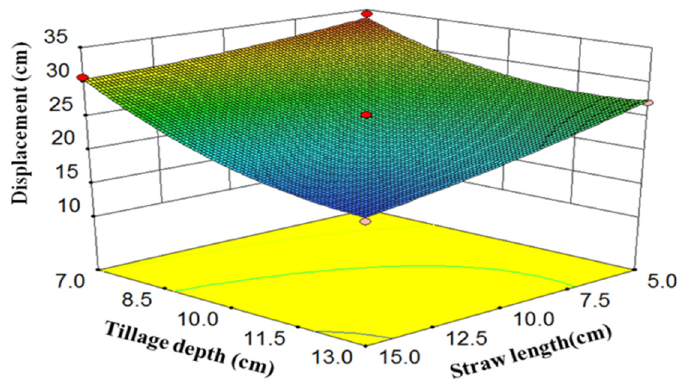
Figure 7. Response surfaces of straw length and tillage depth on straw displacement.